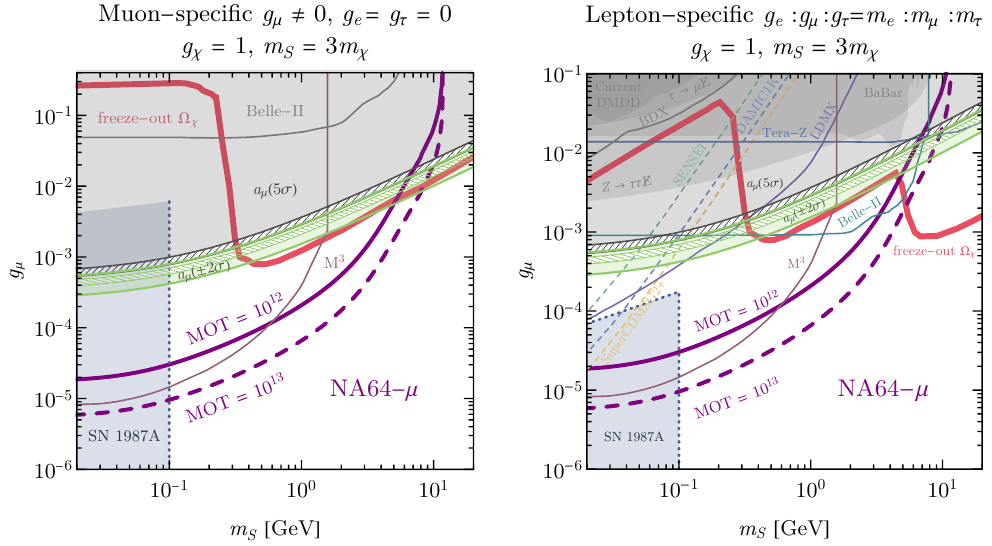
Figure 5. 95% C.L. sensitivity projections for dark scalar searches at NA64- (cid:22) across the g parameter space, along with several other experimental projections and existing constraints. The left and right panels correspond to the muon-speci(cid:12)c ( g (cid:22) 6 = 0, g e = g (cid:28) = 0) and lepton-speci(cid:12)c ( g e : g (cid:22) : g (cid:28) = m e : m (cid:22) : m (cid:28) ) models, respectively. For the two models, we assume m (cid:31) = m S = 3 and g (cid:31) = 1. The solid and dashed purple lines represent the expected NA64- (cid:22) sensitivity with 10 12 and 10 13 MOT, respectively. The red curve indicates the parameters required to reach the correct thermal freeze-out DM abundance. The green and gray regions represent the 2 (cid:27) -favored and 5 (cid:27) -excluded regions based on current a (cid:22) measurements. The hashed regions indicate the projected sensitivity of future a (cid:22) measurements, assuming the current central value stays the same while the experimental and theoretical uncertainties will be improved by a factor of 4 and 2, respectively. The blue region with dotted boundaries represents approximate exclusions from the cooling of SN 1987A. In both panels, we include the sensitivity projections for M 3 [20] and a Belle-II mono- photon search (with 50 fb (cid:0) 1 data) [49]. For the lepton-speci(cid:12)c model, we also include projections for LDMX (with 16 GeV electron beam) [50], BDX [8], mono-photon searches at BaBar [49] and Tera- Z [51], current LDM direct detection limits from XENON 10/100, DarkSide-50, and CDMS HVeV (collectively denoted as \current DMDD"), expected DMDD sensitivities at SENSEI, DAMIC-1K, and SuperCDMS-G2+, as well as constraints from exotic Z and (cid:28) decays. See text for further